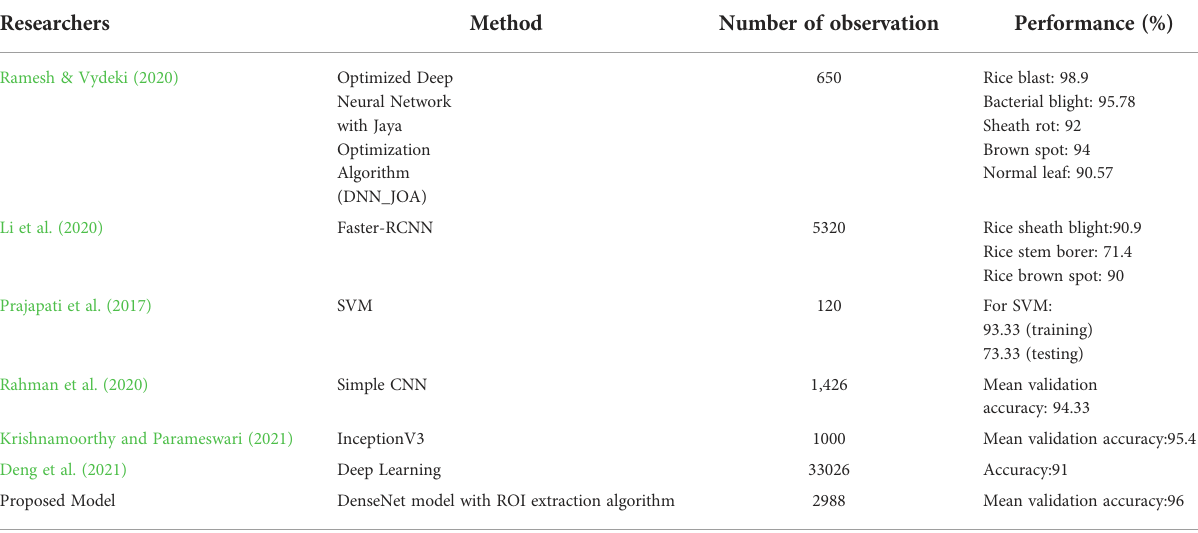
TABLE 8 Comparison of existing related